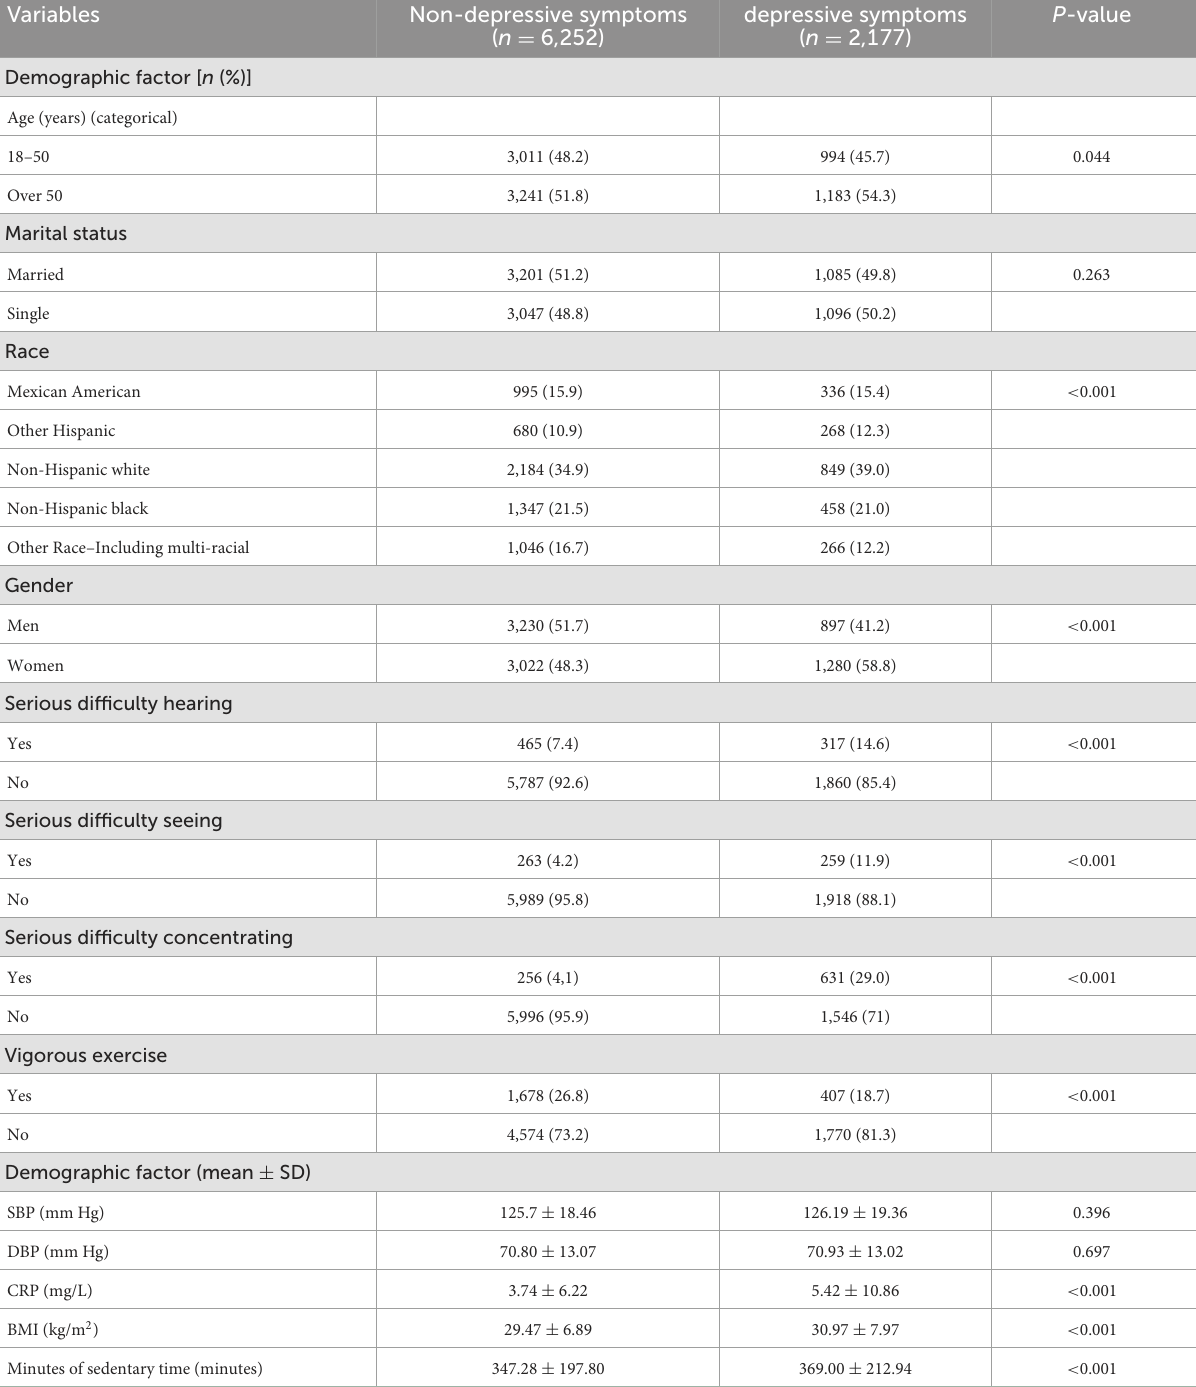
TABLE 1 Basic characteristics of the